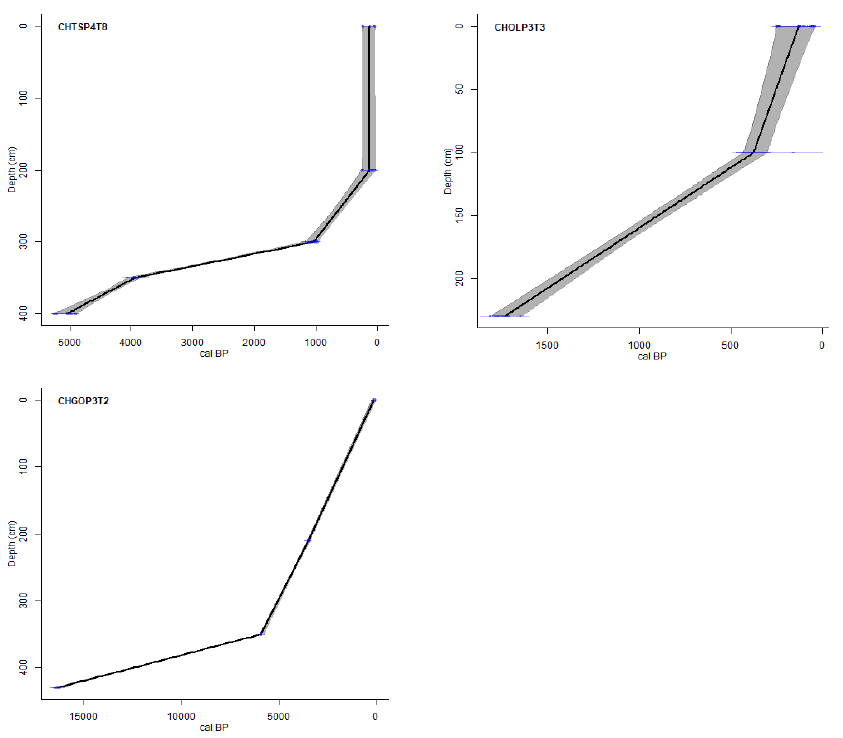
Figure 8. Overview of the coring data based on the sampling depths and radiocarbon ages relations or actual sedimentation rates for selected coring. The blue horizontal lines indicate the sampled and dated depth with 95% probability density, whereas the black line indicates sedimentation history.